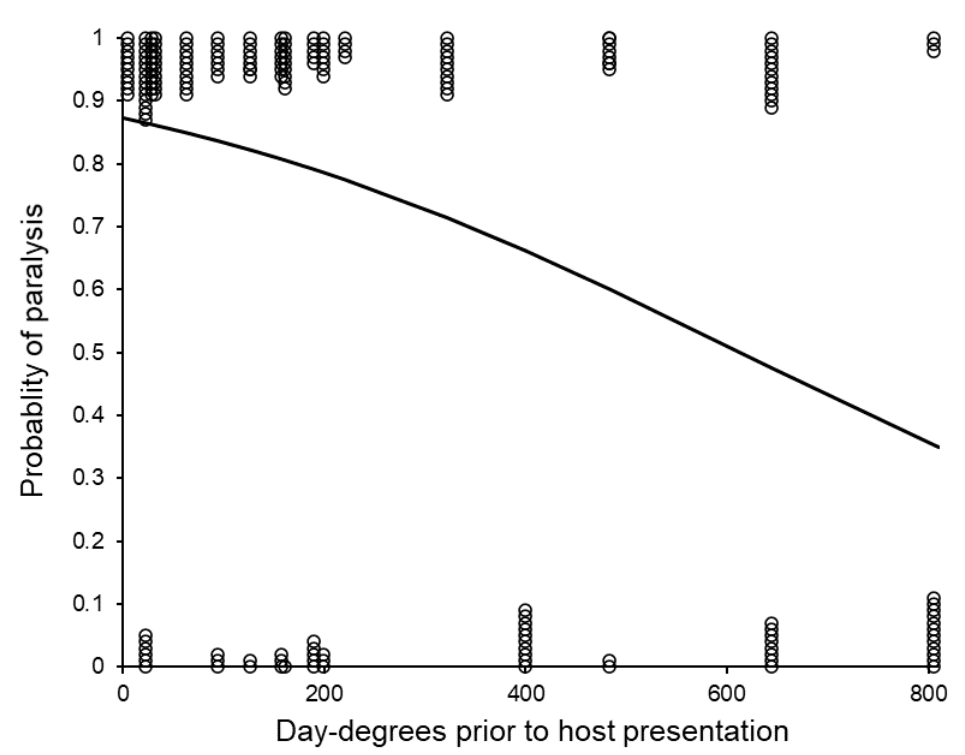
Figure 4. The probability of paralysis by groups of Sclerodermus brevicornis females according to the time and temperature (day-degrees) at which they had been stored. Some data points are displaced from their binary values to reduce overlap and illustrate sample sizes. The fitted curve was estimated using logistic regression (estimated probability = 1 / (1 + (1 / (antiLog e (( − 0.003159 × Day-degrees) + 1.935))))).